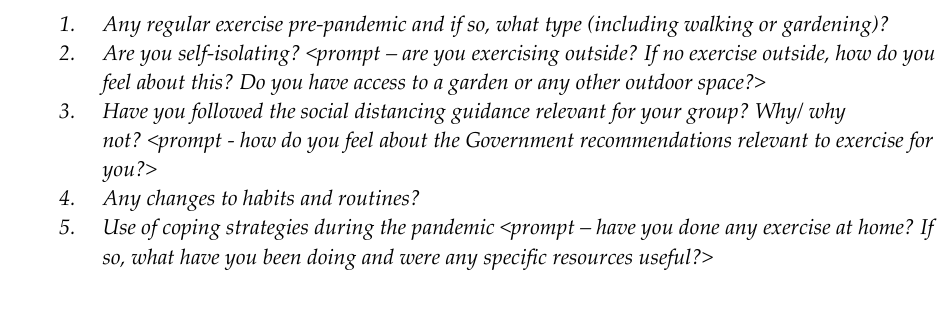
Figure 1. Prompts from the CSS topic guide relating to pandemic-related changes in PA. Interviews were audio recorded and transcribed verbatim by an external service with a UCL data sharing agreement. Transcripts were de-identified prior to